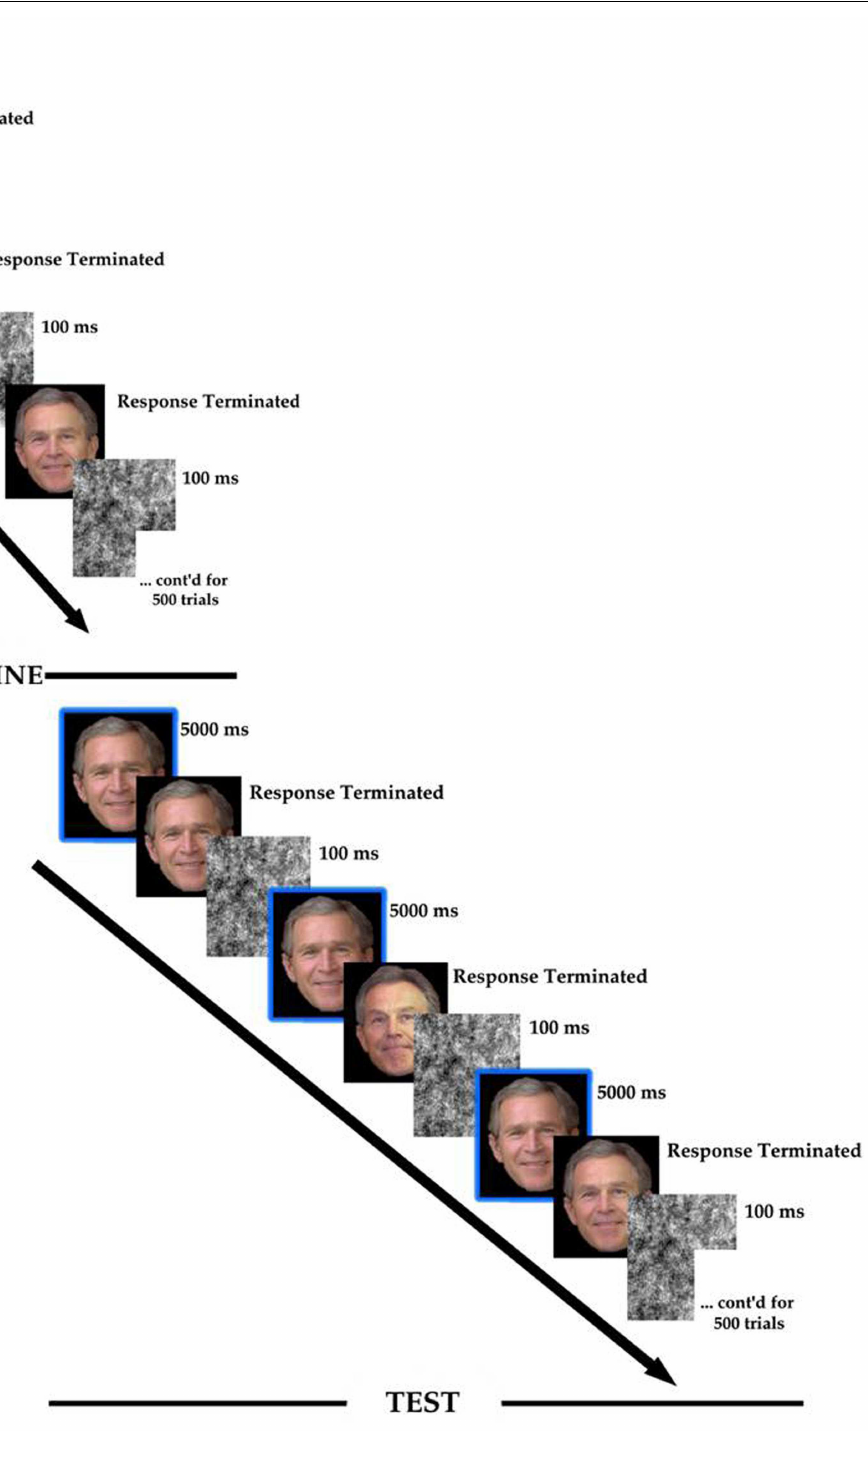
number indicates more identity is needed to perceive the identity of the adaptor, i.e., reduced identity strength. The first analy- sis was a 4 (adaptor type) × 2 (orientation of test stimuli) × 2